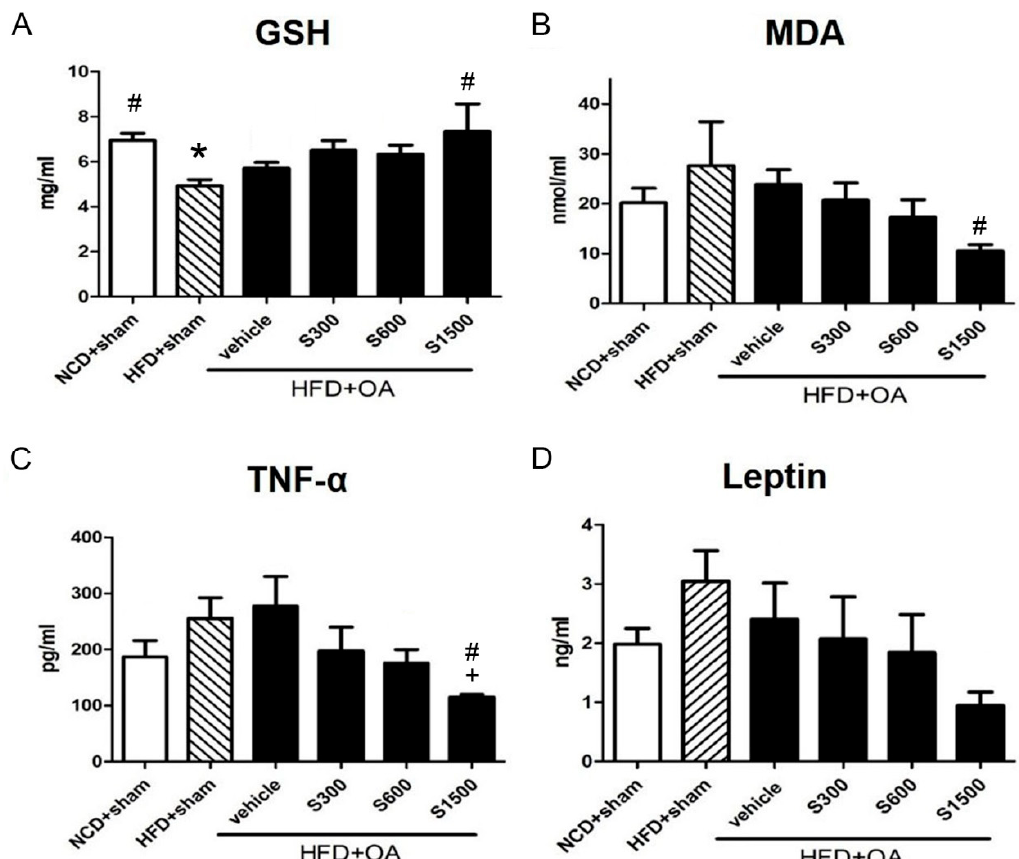
Figure 4. E ff ects of SE on GSH, SOD, MDA, leptin and TNF- α in liver and plasma. Plasma levels of ( A ) GSH, ( B ) SOD, ( C ) MDA, ( D ) leptin and ( E ) TNF- α in all groups. The data are expressed as means ± S.E.M ( n = 6). * p < 0.05 when compared to the NCD + sham group; # p < 0.05 when compared to the HFD + sham group; + p < 0.05 when compared to the vehicle group. The letters were calculated by one-way ANOVA and Duncan’s multiple range test.